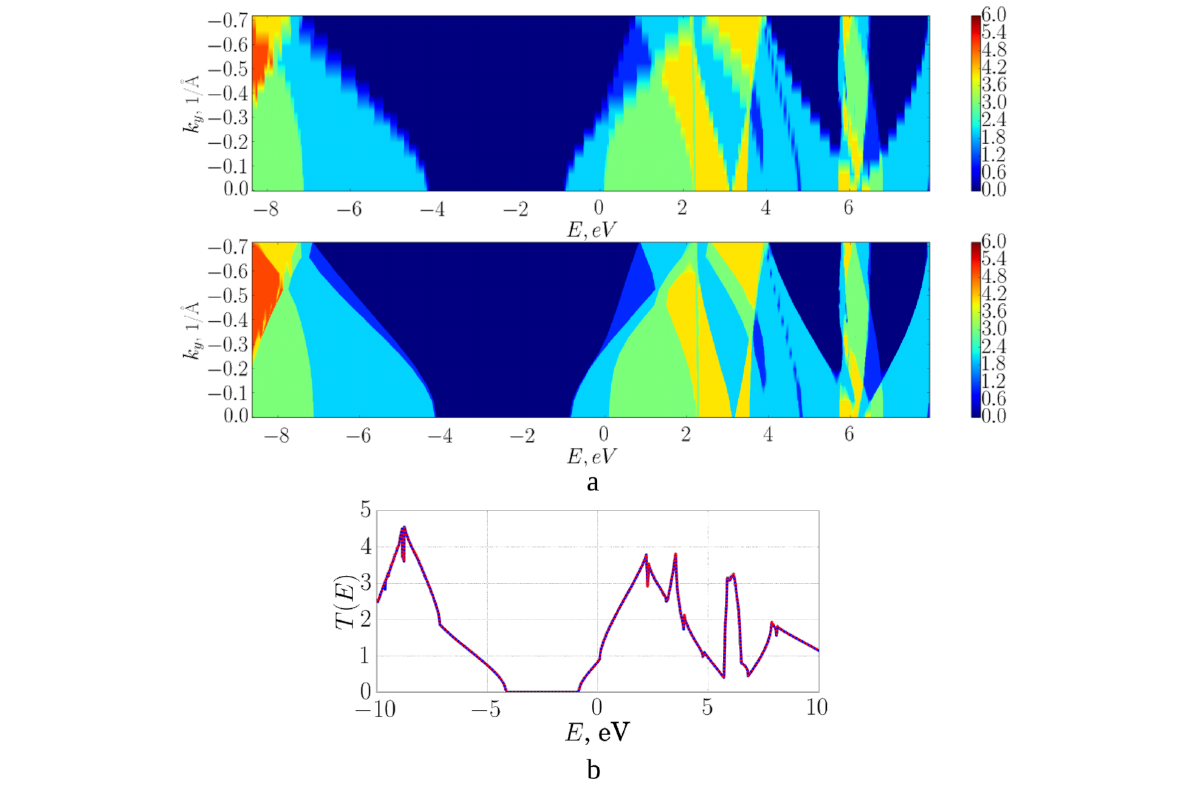
Figure 4: Graphane transmission function: a) a map of T ( E ) for the initial partitioning over k y (top) and (bottom) after applying the interpolating func- tion Т ( Е , k y ); b) averaged T ( E ) over all k y (blue: interpolated, red: